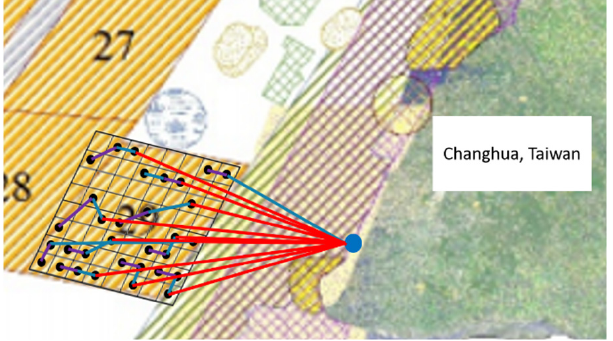
Figure 12. Optimal cable layout by restricting a maximum of three interconnecting turbines. Figure 13. Incorporation of the optimized cable layout onto the map of the planned No. 29 windfarm off the coast of Changhua, Taiwan, to illustrate implementation on an actual site.